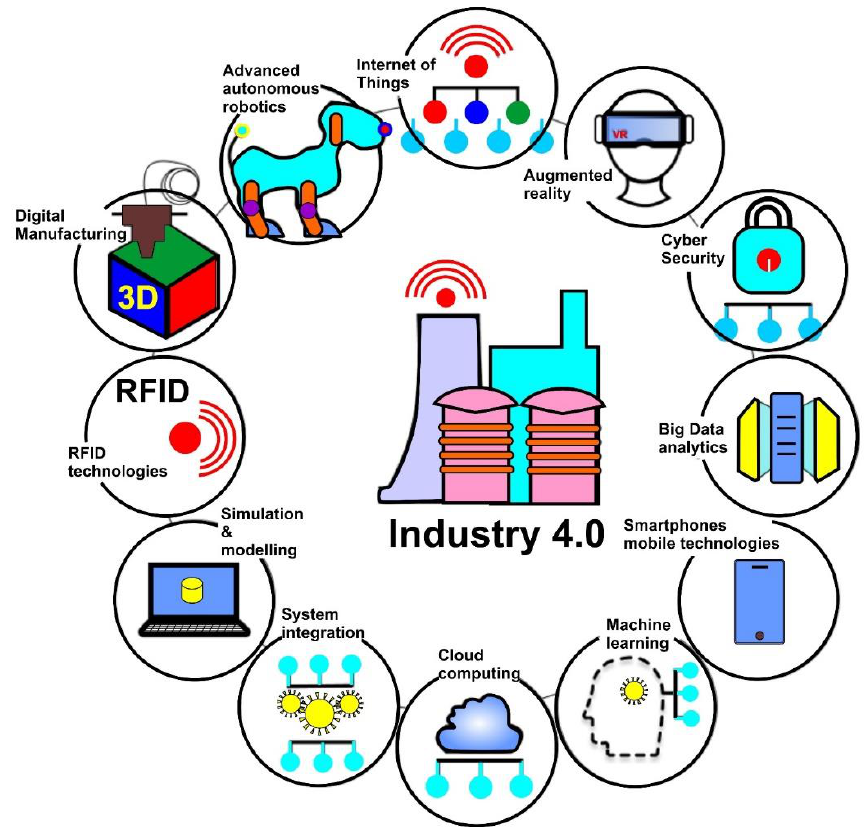
Figure 2. Building blocks of an Industry 4.0 system.